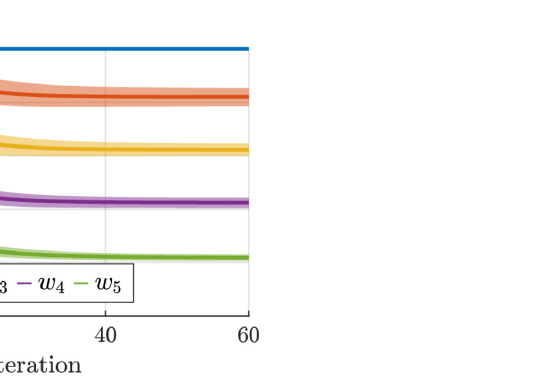
Fig 1. The convergence behavior of our proposed algorithm for randomly synthesized kinematic data. All five parameters converge to their respective optimal value. To obtain the standard deviation, we repeated the process 100 times. The average norm of the final error is 0.07.